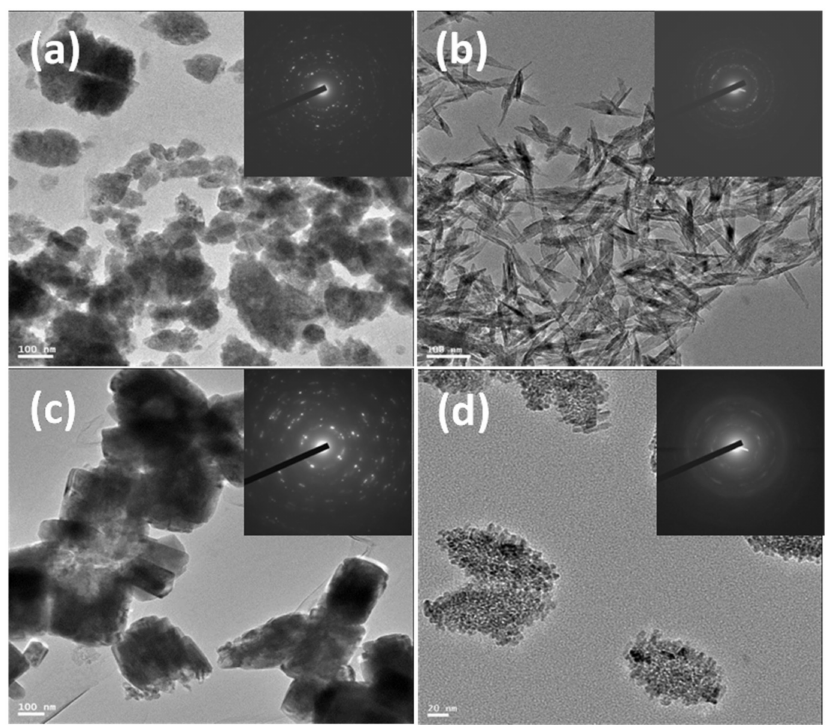
Figure 2. HR-TEM images of water-synthesized ZnO and CuO NPs ( a , b ); scale bar 100 nm; ( c , d ) represent images of ethanol-based synthesized ZnO and CuO NPs, respectively; scale bars 100 and 20 nm.